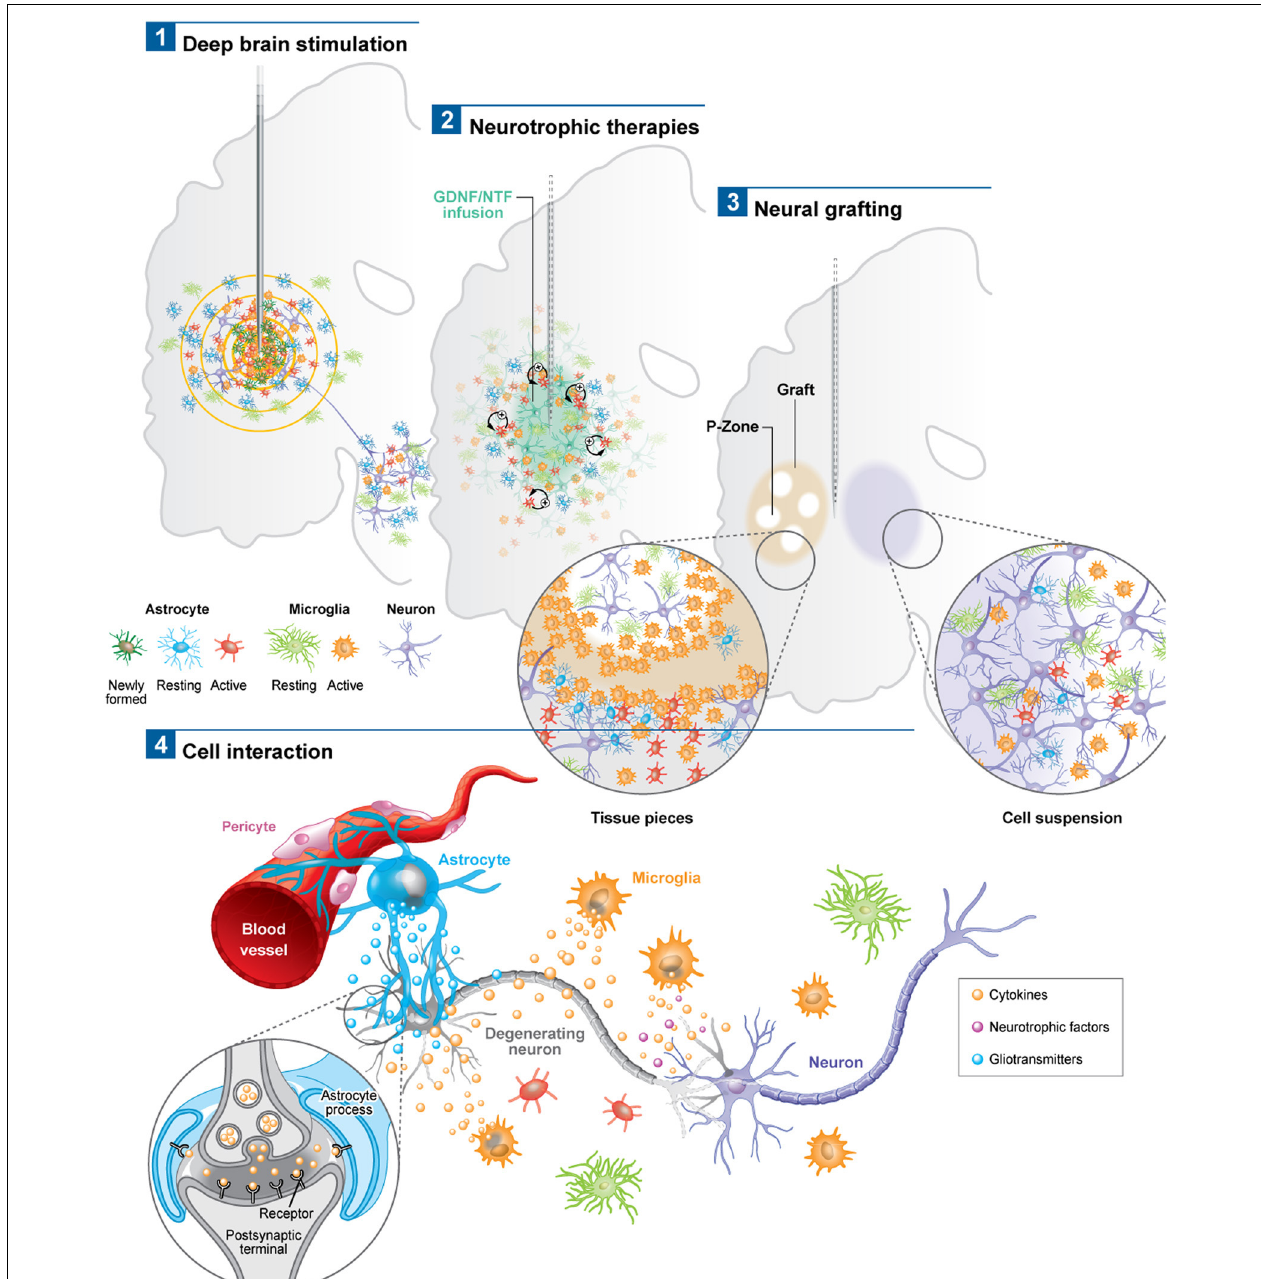
FIGURE 1 | Schematic depicting the astroglial and microglial responses to a variety of invasive experimental therapeutic approaches being trialed for neurodegenerative disorders (1–3). (4) Potential cell interactions that may further influence the outcome of the therapeutic intervention, or, that could be used to potentiate the effects of these therapies. For example the astrocytic response may lead to the release of